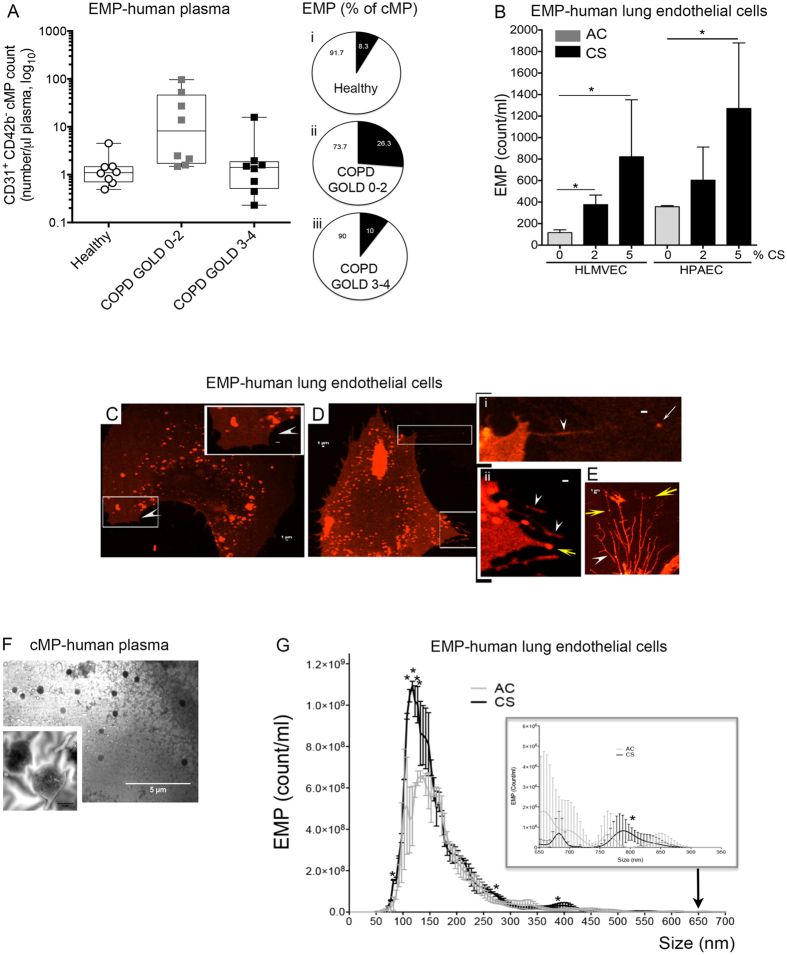
Characterization of microparticles released by CS exposure.(A) Abundance of circulating endothelial microparticles (EMPs) in human plasma (demographics in Supplementary Table 1). Data represent log-transformed CD31+/CD42b- events. ANOVA (p < 0.05; Bartlett’s *p < 0.0001). (B) Abundance of EMPs released from primary human lung microvascular (HLMVEC) and human pulmonary artery (HPAEC) endothelial cells exposed to CS or ambient air (AC) extract (v:v %; 2 h). Mean + SEM; ANOVA (p < 0.001; Tukey’s *p < 0.05, n = 5). (C–E) Representative images (n = 3) from videos (in Supplementary material) of HLMVEC transduced with plasma membrane-RFP-BacMan and exposed to AC ((C) protruding lamellipodia: arrowhead; insert); or to CS (5%, 1 h, (D) and insets; or 2%, 30 min, (E)). Note EMPs (yellow arrow) released from the plasma membrane at tips of retracting filopodia (arrowhead). (F). Transmission electron microscopy micrograph of heterogeneous human plasma cMPs. (G). Abundance and size distribution of EMPs released from AC- and CS-exposed HLMVEC (5%; 2 h) measured by NanoSight-NS300 (Mean+/−SD; n =  3). CS released mostly EMPs 50 nm–200 nm (mode 129 nm; exosome fraction). t-test *p < 0.05 for sizes 82–92 nm, 107–127 nm, 262–277 nm, 372–387 nm, and 790–820 nm.